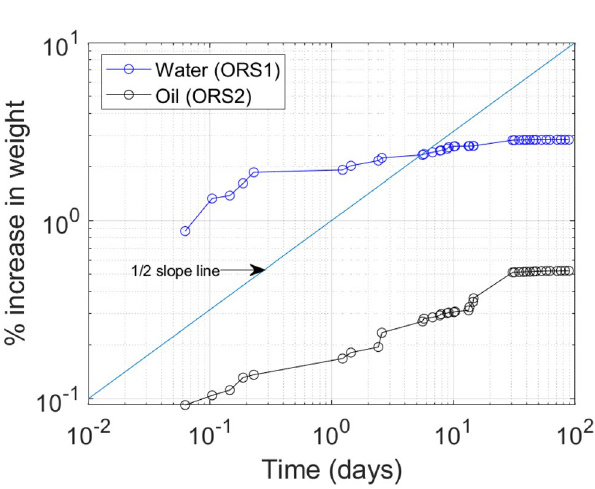
Figure 4. Illustrative examples of ( a ) water droplet CA and ( b ) complete spreading of oil droplet.